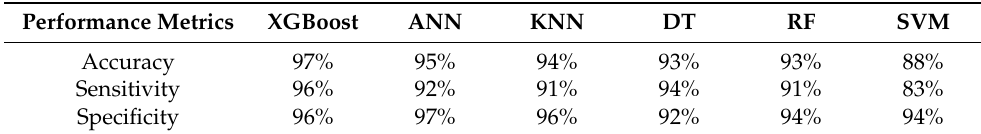
Table 3. Comparison between XGBoost model and state-of-the-art